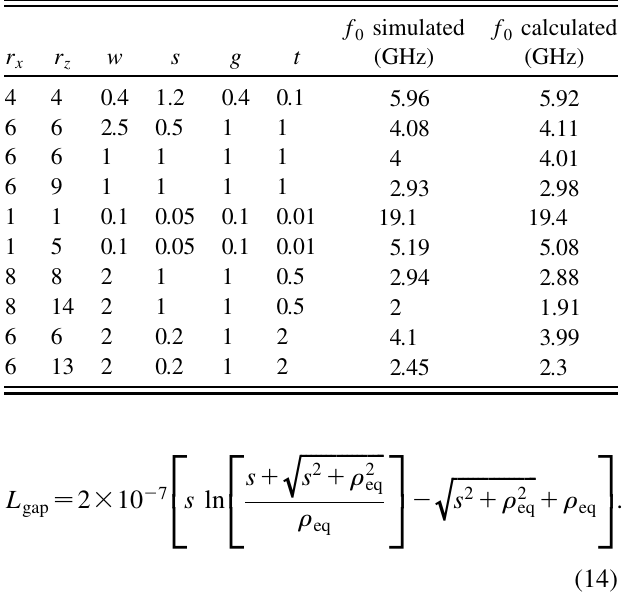
TABLE III. Comparison between simulated and calculated CSRR resonance frequencies. All dimensions are in